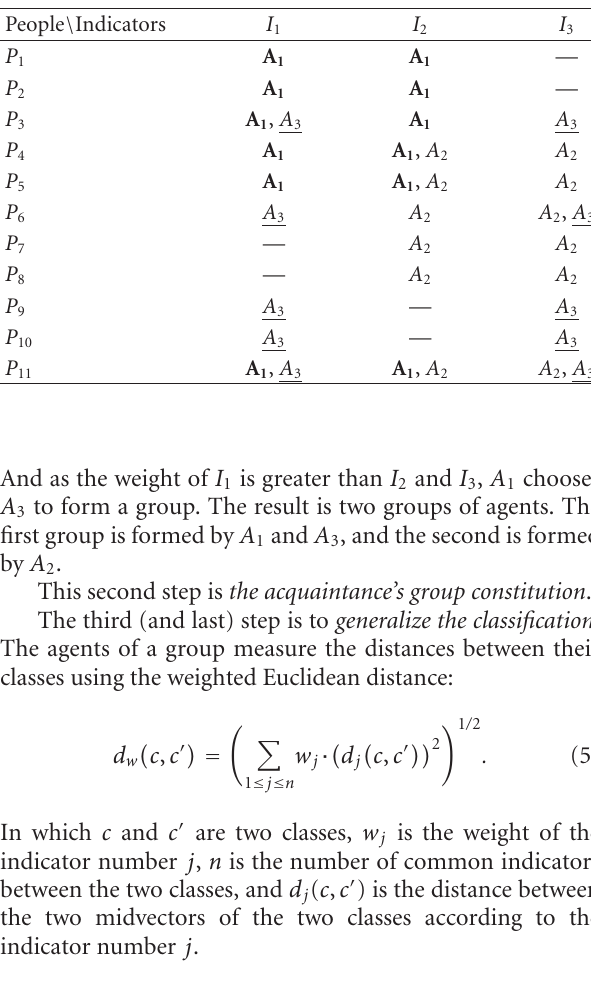
Table 2: Distribution people/indicators.